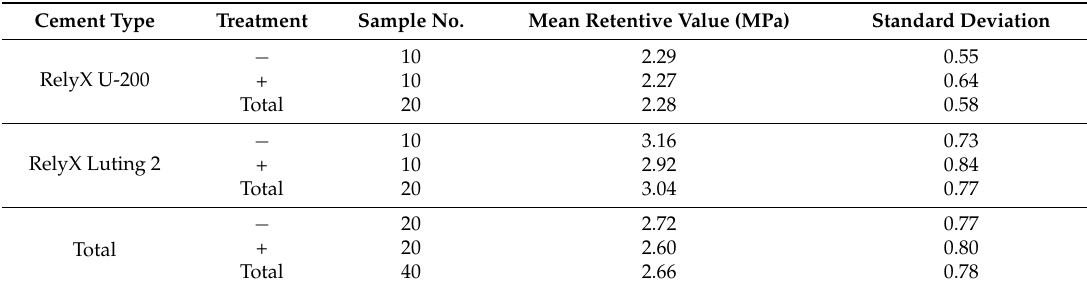
Table 1. Means (SD) of the retentive strength (MPa) of the zirconium-oxide crowns for all cementation groups.